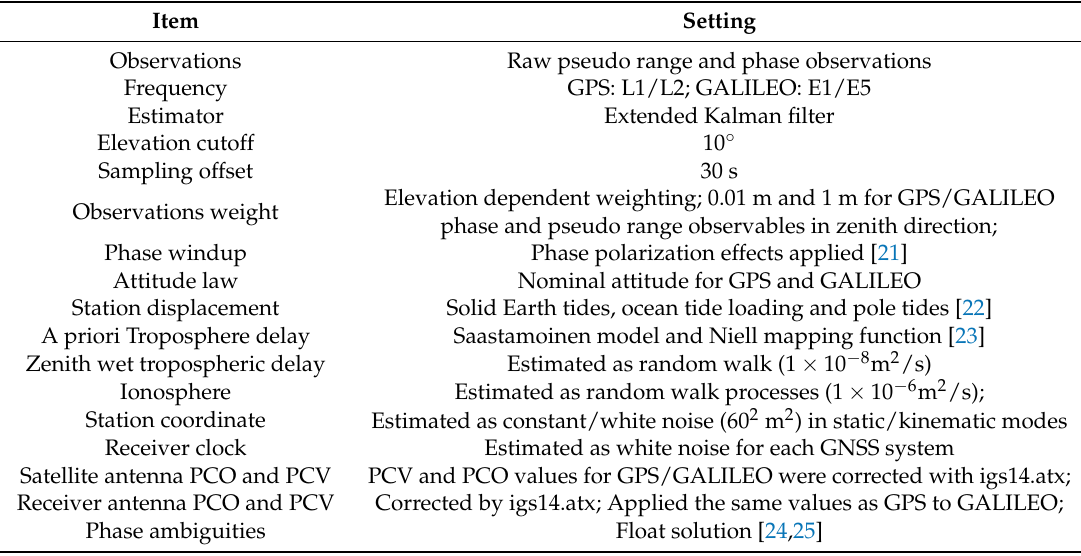
Table 2. Strategies for RT GPS/GALILEO